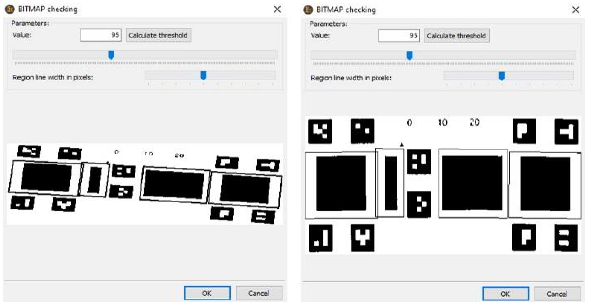
Figure 15. Interfaces of solutions for the image with an angle of inclination 50 degrees: on the left - according to the original image; on the right - after prior image rectification.